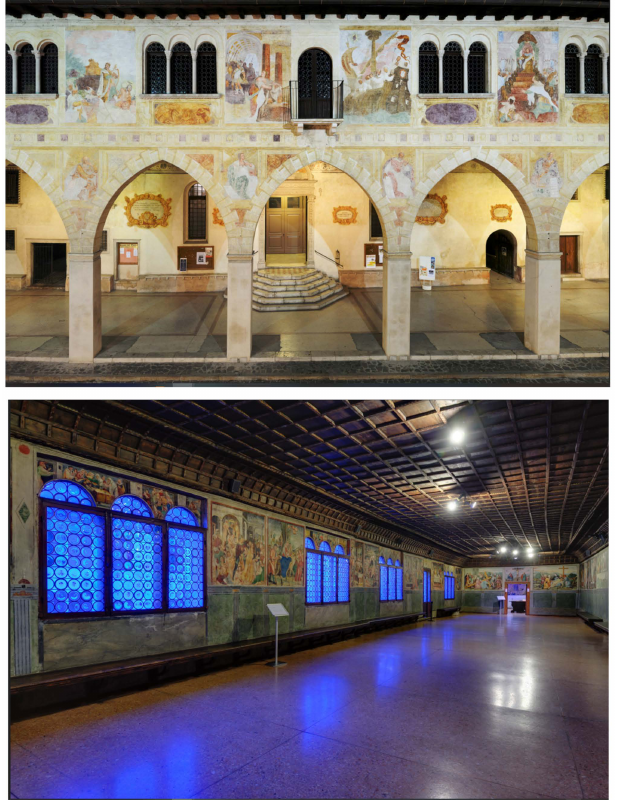
Figure 6. The Battuti’s meeting room (porch XV sec., frescoes XVI). ( Top ): external decorations of the façade. ( Bottom ): interior